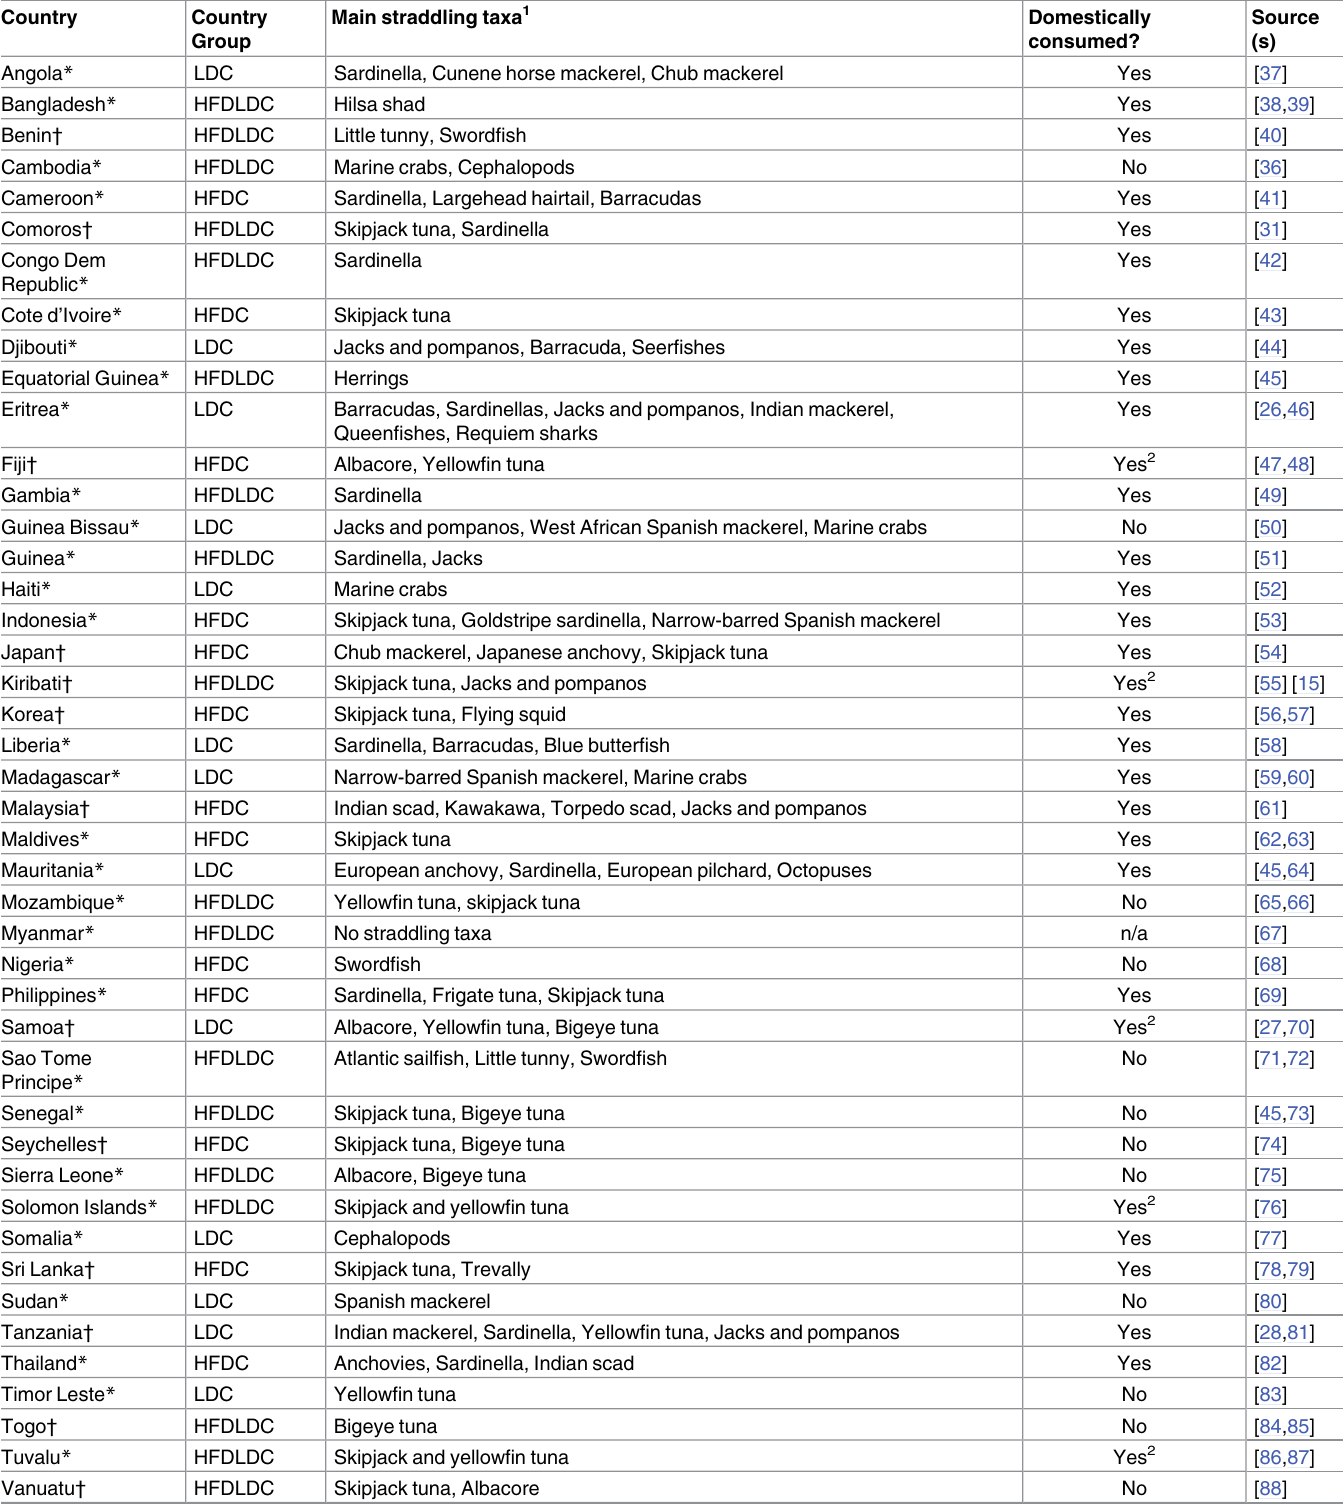
Table 3. Summaryof main straddling fish taxa caught by each country, and whether the fish taxa are consumed domestically.